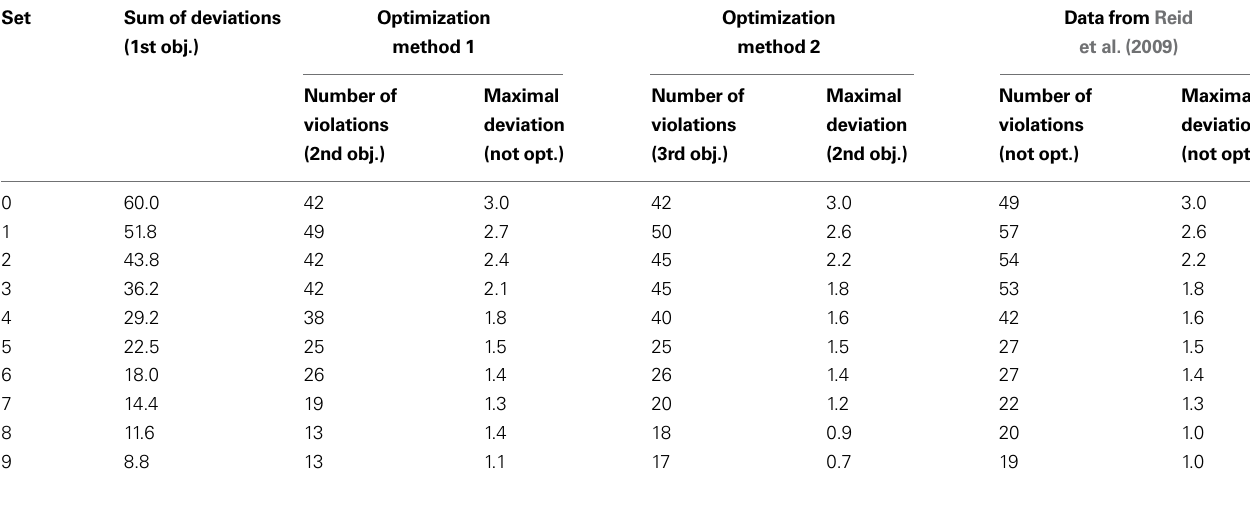
Table 2 | The results of the